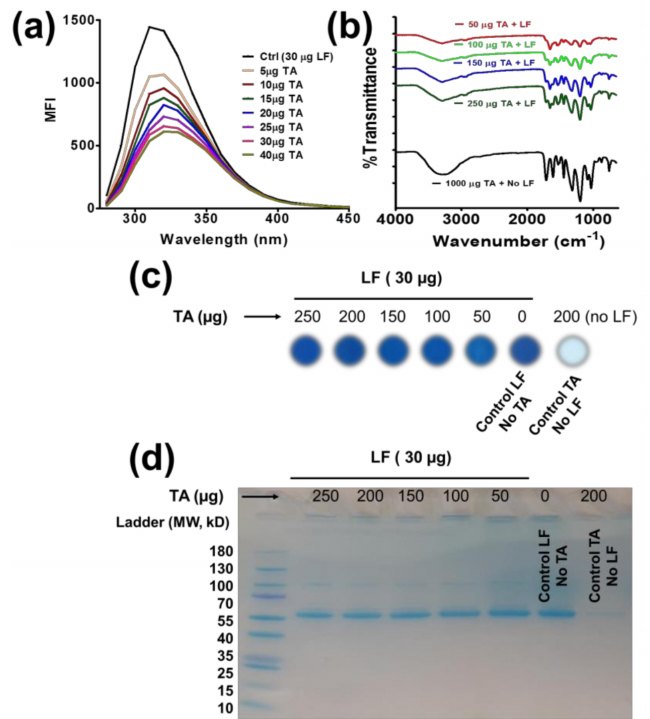
Figure 1. Spectral and biological confirmation of TA-LF complex formation. ( a ) Instant binding and self-assembly/complex formation of LF and TA was measured by measuring fluorescence (FL) quenching. Representative FL quenching profiles of 30 µ g/mL LF with increased TA solution (5–40 µ g) at room temperature ( λ ex = 295 nm). ( b ) FTIR spectra of TA and TA-LF complexes. Characteristic peaks at 1653 and 1525 cm − 1 represent the presence of LF in TA-LF complexes. ( c , d ) Protein dot and SDS-PAGE confirms presence of LF proteins in TA-LF complexes by visual evidence. Coomassie Blue stains lung fluid protein in TA-LF assemblies but not free tannic acid. ( a , c , d ) Data acquired from 3 sets of samples for